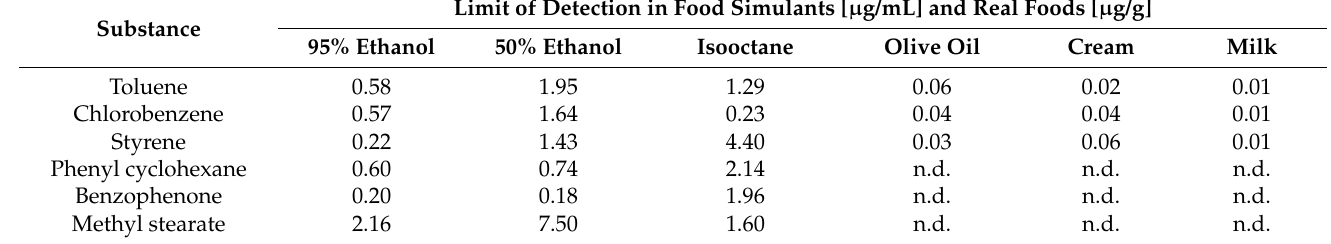
Table 7. Within laboratory detection limit in food simulants [ µ g/mL] and real foods [ µ